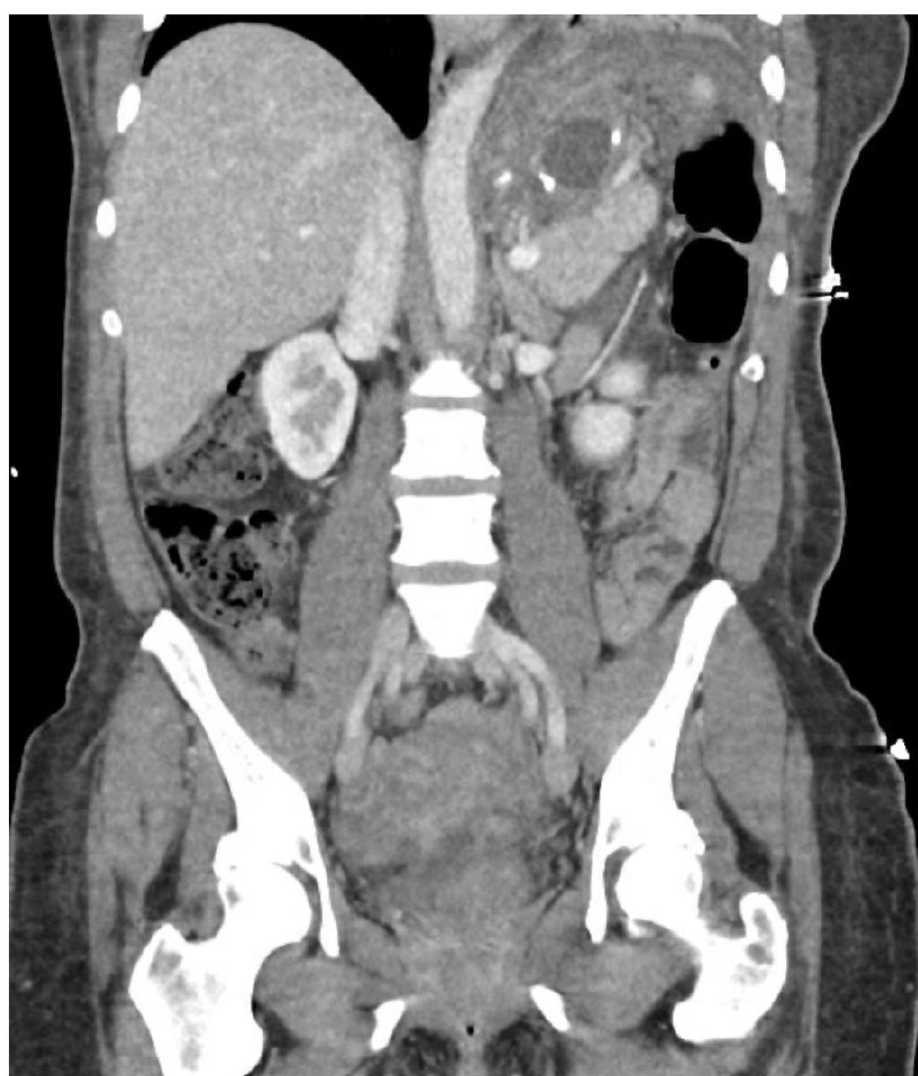
Figure 1. Initial CT showing LUQ abscess. The patient underwent a sinogram that showed the drain was in an apparent abscess cavity. An upper gastrointestinal contrast study (Figure 2) and CT sinogram both failed